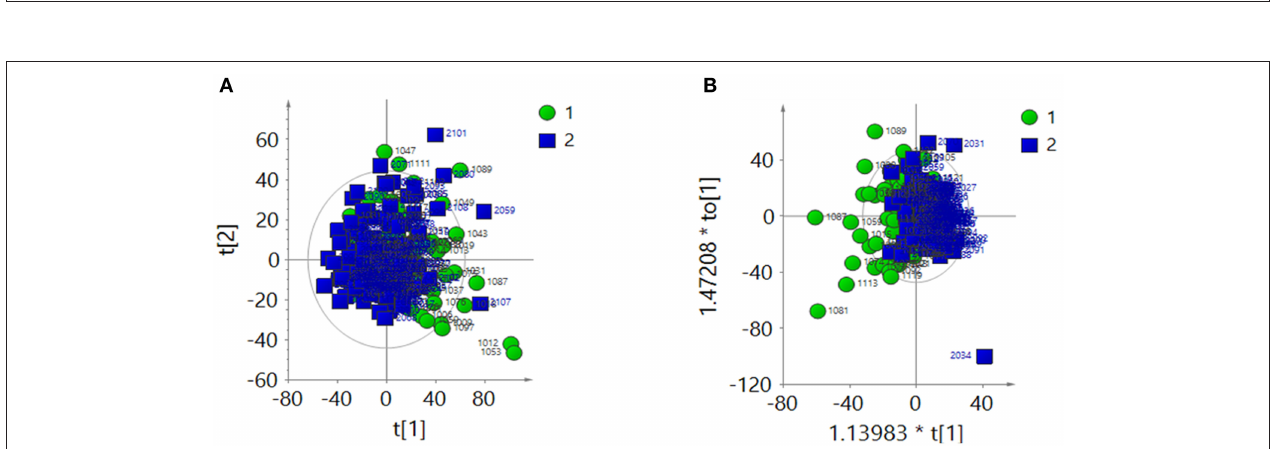
FIGURE 2 | After the creatinine normalization, multivariate analysis results of 1 H-NMR spectra of urine samples from the ASD group (green dots, 1) and control group (blue squares, 2). (A) PCA score plot: R 2 X = 0 403, Q 2 = 0.135. (B) OPLS-DA score plot: R 2 X = 0.257, Q 2 = 0.0138, CV-ANOVA P =